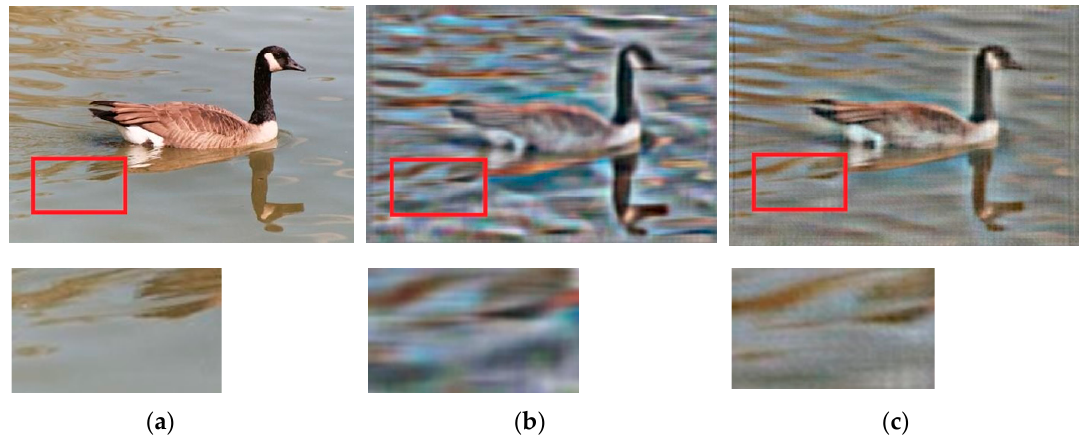
Figure 1. Comparison of our visualization with other visualization methods. ( a ) Original image; ( b ) HOG visualization [28]; and ( c ) HOGP feature visualization.